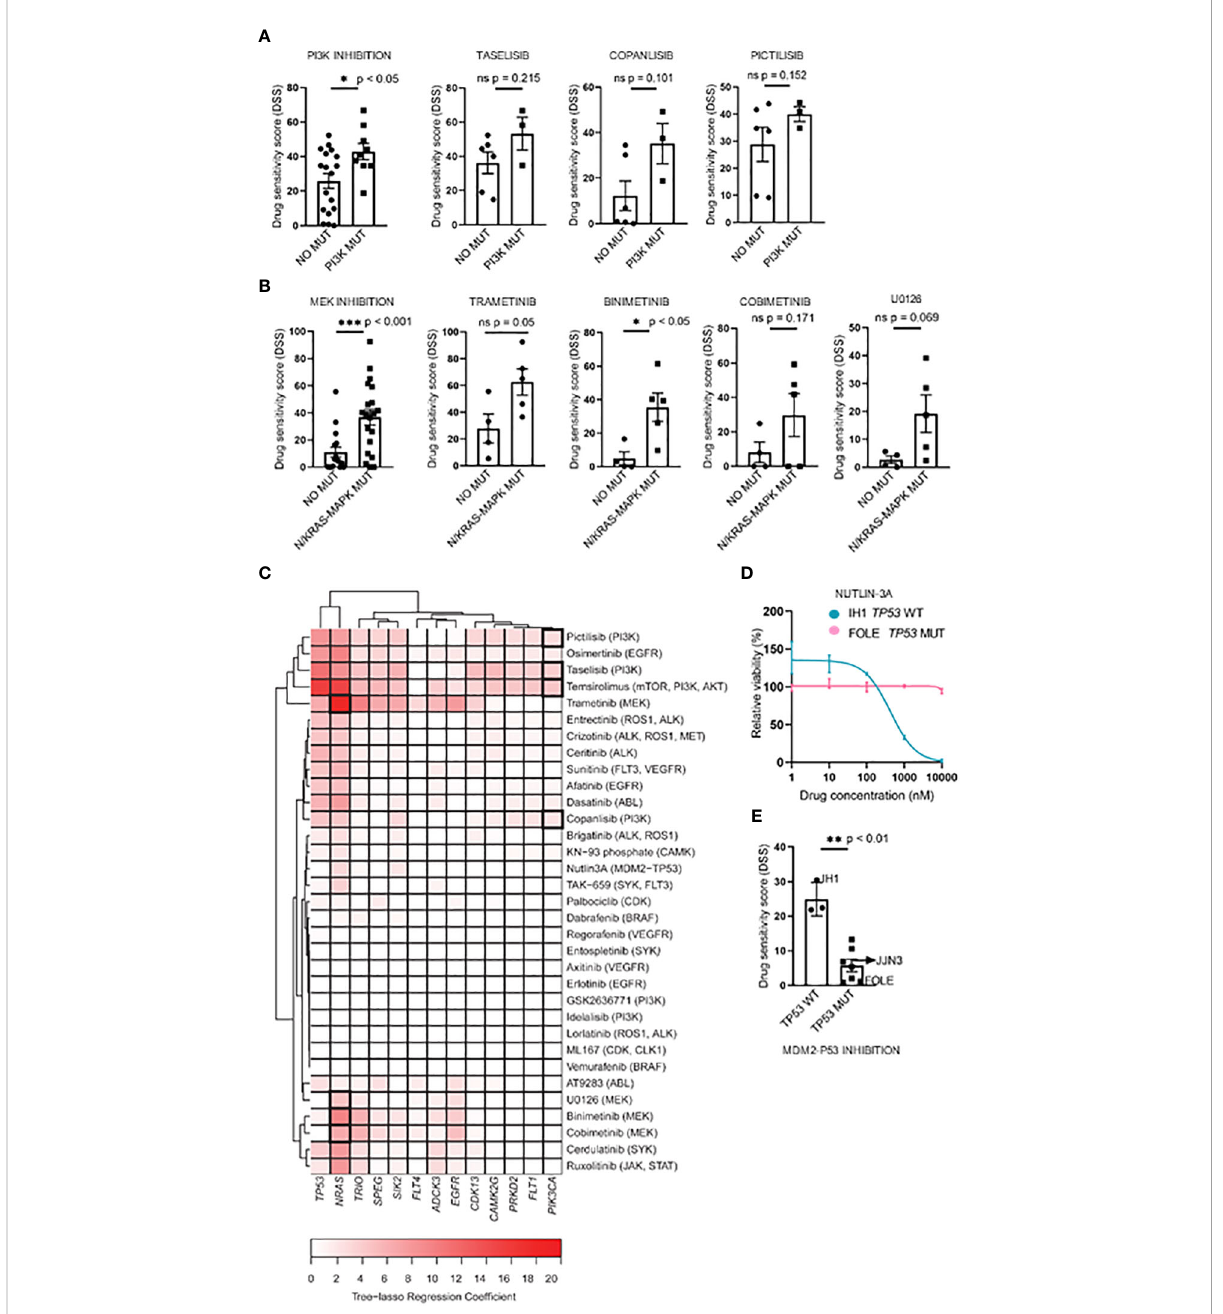
FIGURE 3 Associations between drug sensitivity and mutational pro fi les in MM cell lines. (A, B) , Pharmacogenomic comparison between PI3K and RAS mutation status and DSS to PI3K and MEK inhibitors. Aggregated (left) and individual drug (middle-left) effects are shown. The graph shows mean DSS ± SD. (C) , Heatmap of the tree-lasso regression coef fi cients for DSS as a function of mutations, where the rows are all the possible selected features (i.e., genes whose regression coef fi cients are exactly zero for all drugs were excluded from the plot, as well as those coef fi cients that, for every drug, are lower in absolute value than 5% of the sum of all coef fi cients for the given drug). Framed rectangles highlight the predictive power of NRAS and PIK3CA for the responses to MEKi and PI3Ki, respectively. (D) , Concentration-response curves of cell viability for nutlin-3A in the IH1 and FOLE MM cell lines that differ in TP53 mutational status. The graph shows mean viability ± SD (n=3). (E) , Association of the TP53 mutation status with nutlin-3A sensitivity for all 10 MM cell lines. The graph shows mean DSS ± SD. Statistics were performed using Welch ’ s test. Statistics were performed using Welch ’ s test. *p < 0.05, **p < 0.01, ***p < 0.001, ns (not signi fi